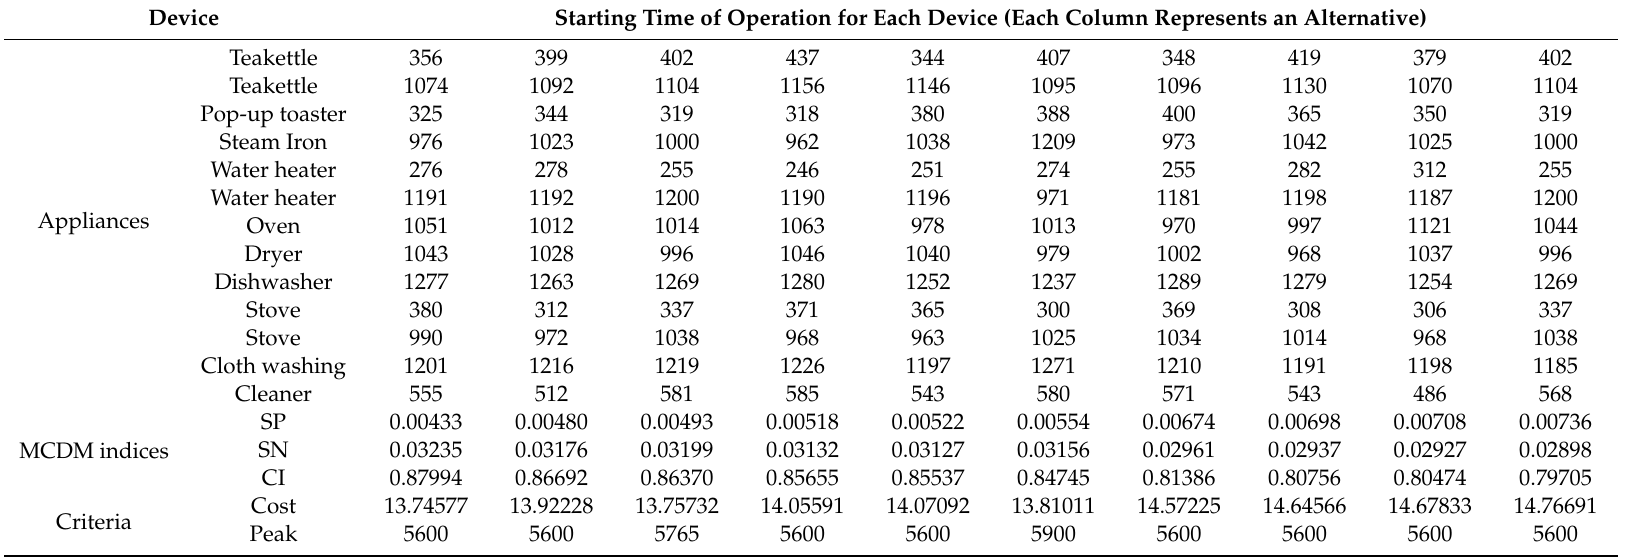
Table 10. Average scores based on integrated AHP-TOPSIS for all